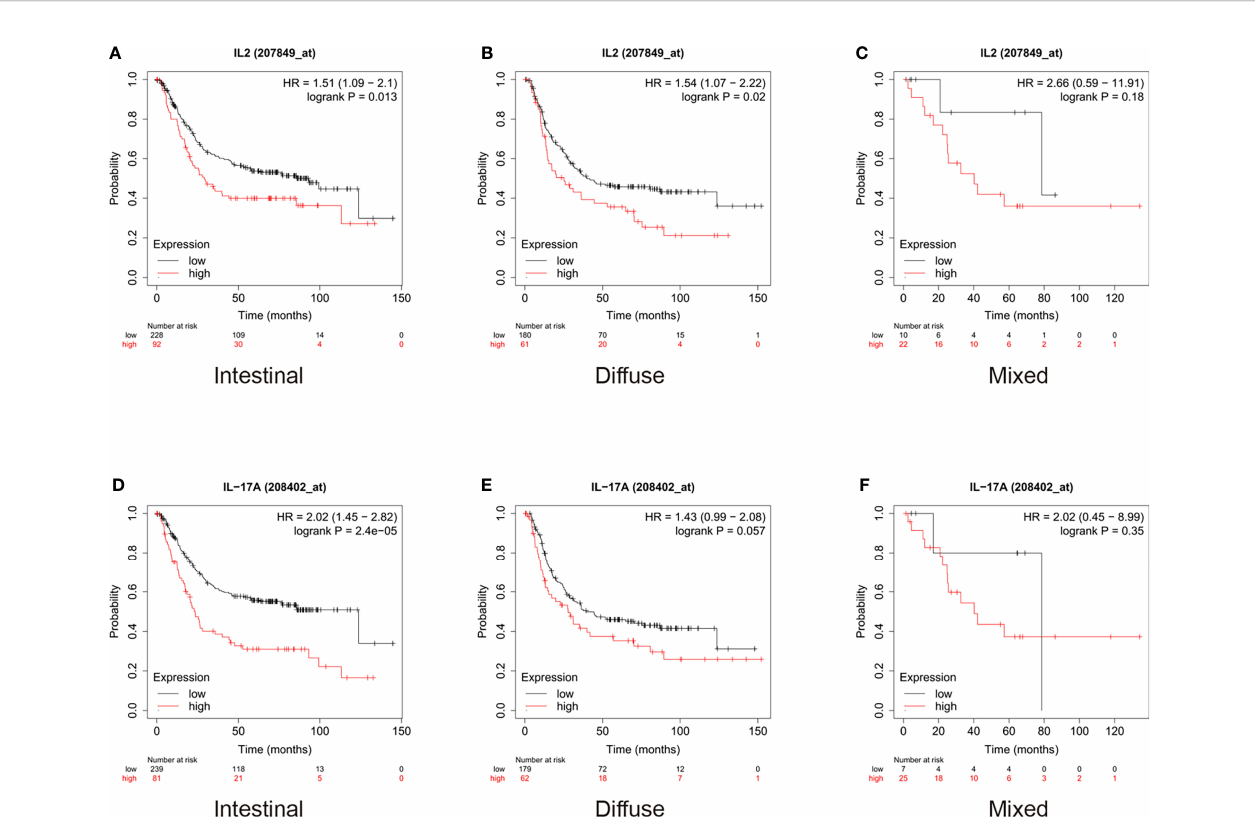
FIGURE 6 | In gastric cancer patients, high expression of interleukin (IL)-2 indicated worse prognosis in patients with both intestinal and diffuse conditions and high expression of IL-17 indicated worse prognosis only in patients with intestinal condition. (A, B) High expression of IL-2 indicated worse prognosis in patients with both intestinal (hazard ratio [HR] = 1.51, p = 0.013) and diffuse (HR = 1.54, p = 0.3) conditions. (C) High expression of IL-2 did not signi fi cantly in fl uence survival in mixed patients (HR = 2.66, p = 0.18). (D) High expression of IL-17 indicated worse prognosis in patients with intestinal conditions (HR = 2.02, p < 0.001). (E, F) High expression of IL-17 did not signi fi cantly in fl uence survival in patients with diffuse (HR = 1.43, p = 0.057) and mixed (HR = 2.02, p = 0.35)